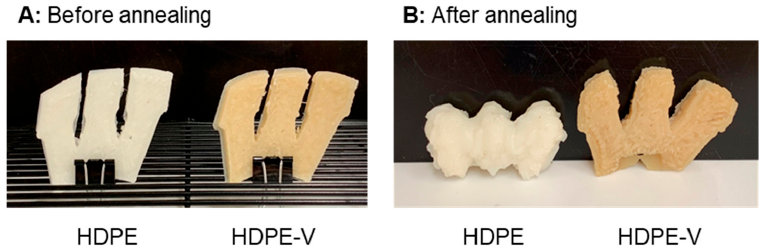
Figure 9. Visual demonstration of the annealing process: ( A ) before placing the parts in the oven, and ( B ) after 10 min in the oven at 150 °C.